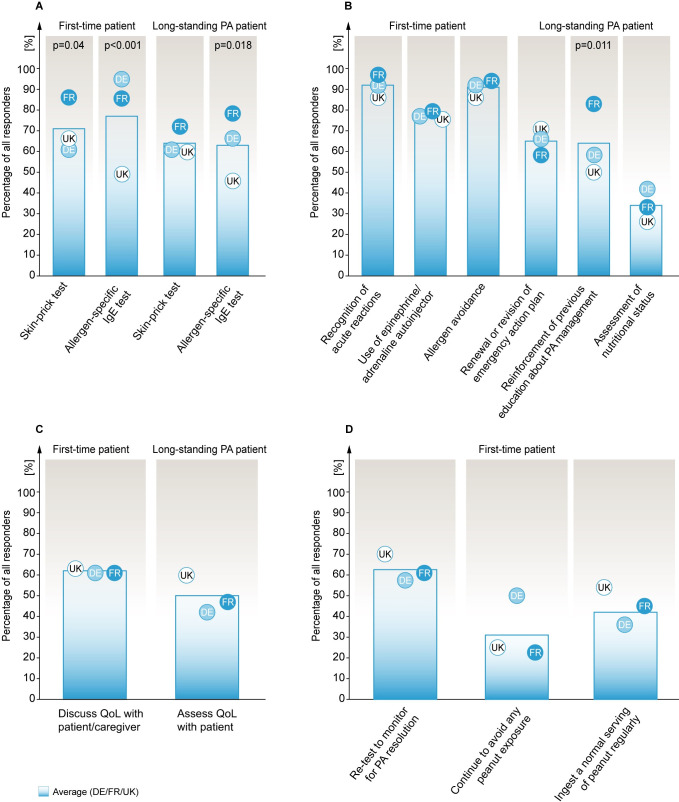
Primary assessment approaches towards PA diagnosis and management.Panels A-D: Percentage of all responses are shown. A. Choices of diagnostic tests performed to confirm PA for the first-time patient with potential PA and a long-standing patient for re-confirming PA. B. Topics discussed by allergists at the initial office visit with a first-time or long-standing patient with PA and their caregivers. C. Discussions about QoL with patients/caregivers. D. Monitoring for resolution of PA after confirming the diagnosis in a first-time PA patient. Blue gradient bar shows average results for responses from France (FR), Germany (DE) and the United Kingdom (UK) (n = 109; FR (36), DE (38), UK (35)), and circles represent individual countries with the respective two-letter acronym. Only statistically significant p values from Chi-Square distribution analyses comparing differences among the three individual countries. (p ≤ 0.05). IgE, Immunoglobulin E; PA, peanut allergy; OIT, oral immunotherapy; OFC, oral food challenge.